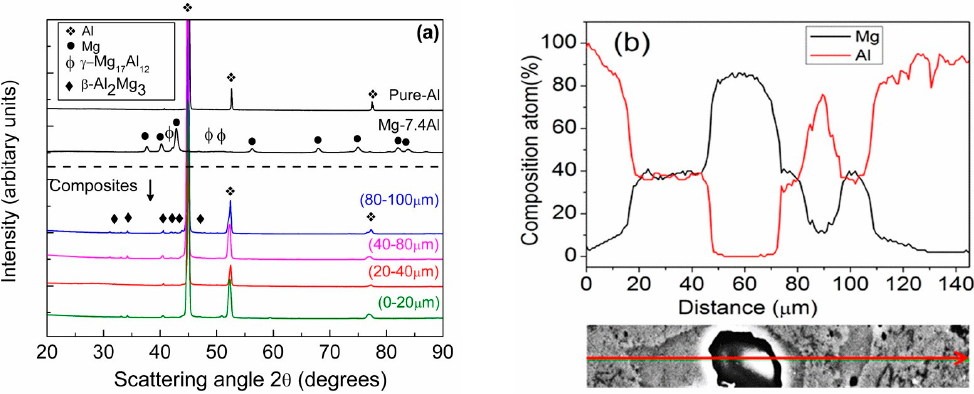
Figure 1. ( a ) X -ray diffraction (XRD) patterns for pure Al, mechanically alloyed Mg-7.4%Al powder and Al-based composites reinforced with different particle size; ( b ) compositional line profiles obtained from energy dispersive X -ray (EDX) analysis for the composite reinforced with (80–100 µ m) particle size. The SEM micrographs of the composites with (80–100 µ m) particle size of the